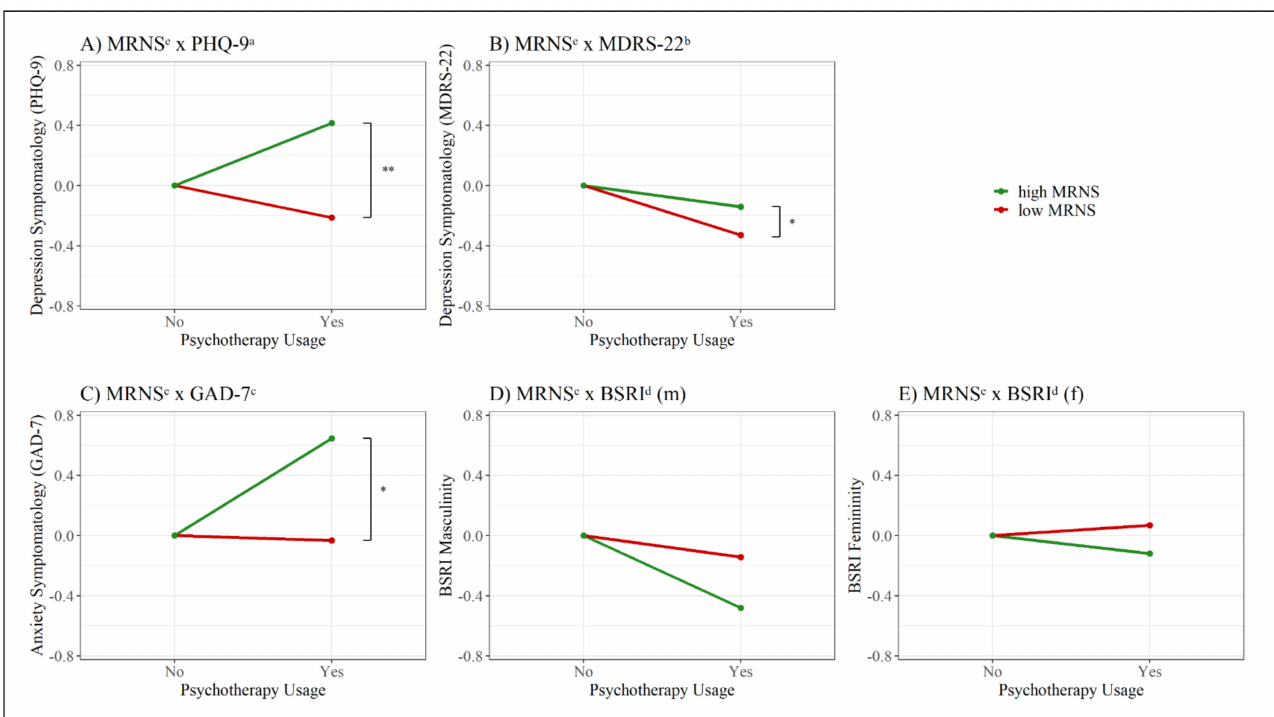
Figure 5. Interaction effects in male participants. ( A ) MRNS e x PHQ-9 a ; ( B ) MRNS e x MDRS-22 b ; ( C ) MRNS e x GAD-7 e ; ( D ) MRNS e x BSRI d (m); ( E ) MRNS e x BSRI d (f). Note: x = interaction, m = masculine subscale, f = feminine subscale. The questionnaire values on the y-axis were z-standardized and linearly transformed to have a joint reference point a y = 0; a PHQ-9 = Patient Health Questionnaire-9; b MDRS-22 = Male Depression Risk Scale-22; c GAD-7 = Generalized Anxiety Disorder-7; d BSRI = Bem Sex Role Inventory; e MRNS = Male Role Norm Scale; * = p < 0.05, ** = p <